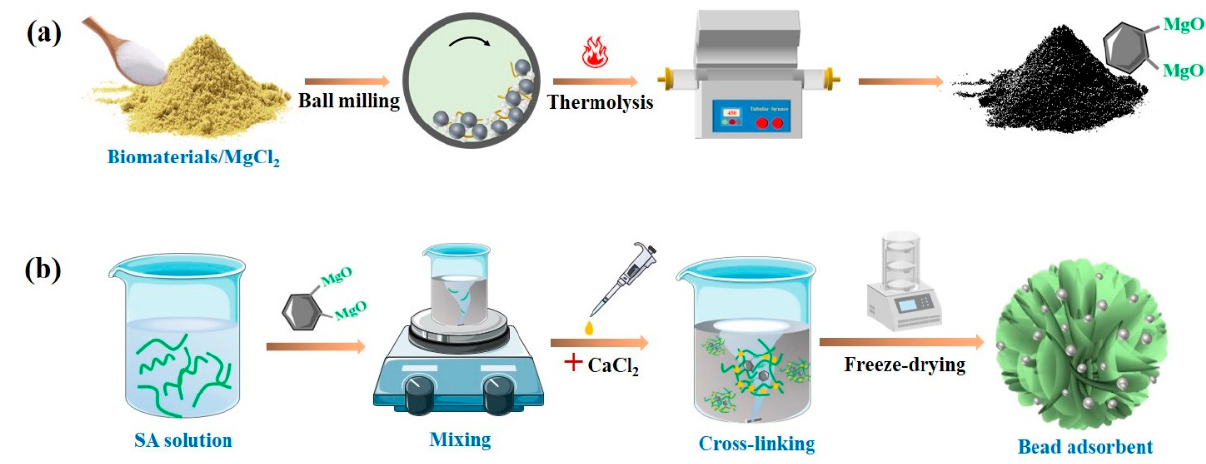
Figure 1. Schematic diagrams for the ( a ) MgBC and ( b ) bead preparation.